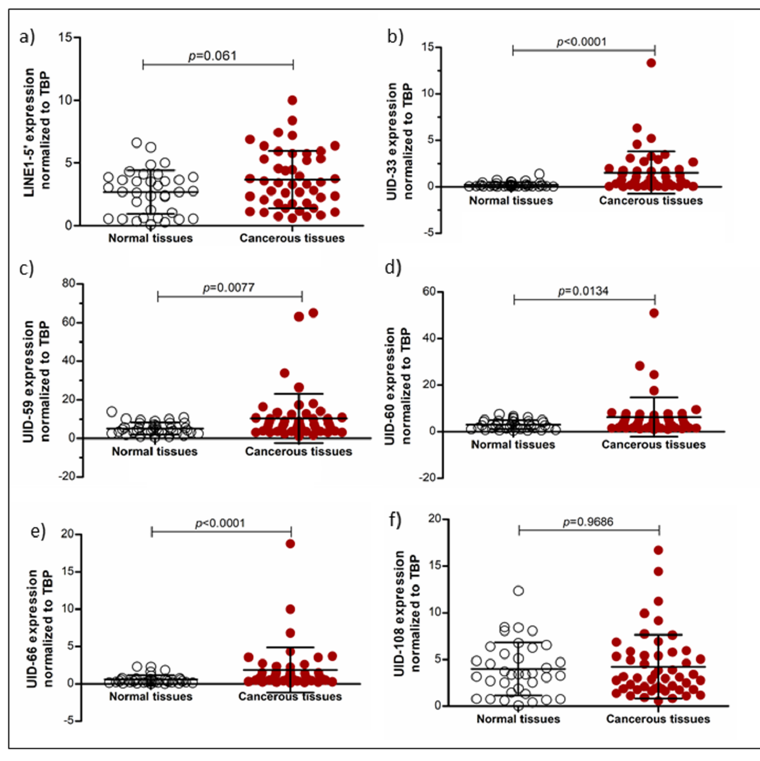
Figure 3. L1 expression in normal and cancerous bladder tissues. The expressions of L1s in bladder cancer ( n = 51) and normal tissues ( n = 36) were measured by qRT-PCR for overall long interspersed element 1 (LINE-1, L1) ( a ), and the individual elements UID-33 ( b ), UID-59 ( c ), UID-60 ( d ), UID-66 ( e ) and UID-108 ( f ). TBP was used as a reference gene. Statistical comparisons were performed by the Mann-Whitney U-test. Int. J. Mol. Sci. 2020 , 21 , x FOR PEER REVIEW